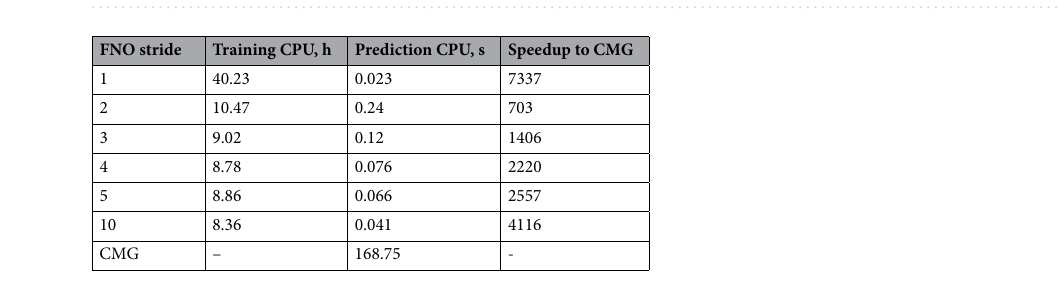
Figure 6. Realizations of porosity of the storage zone.